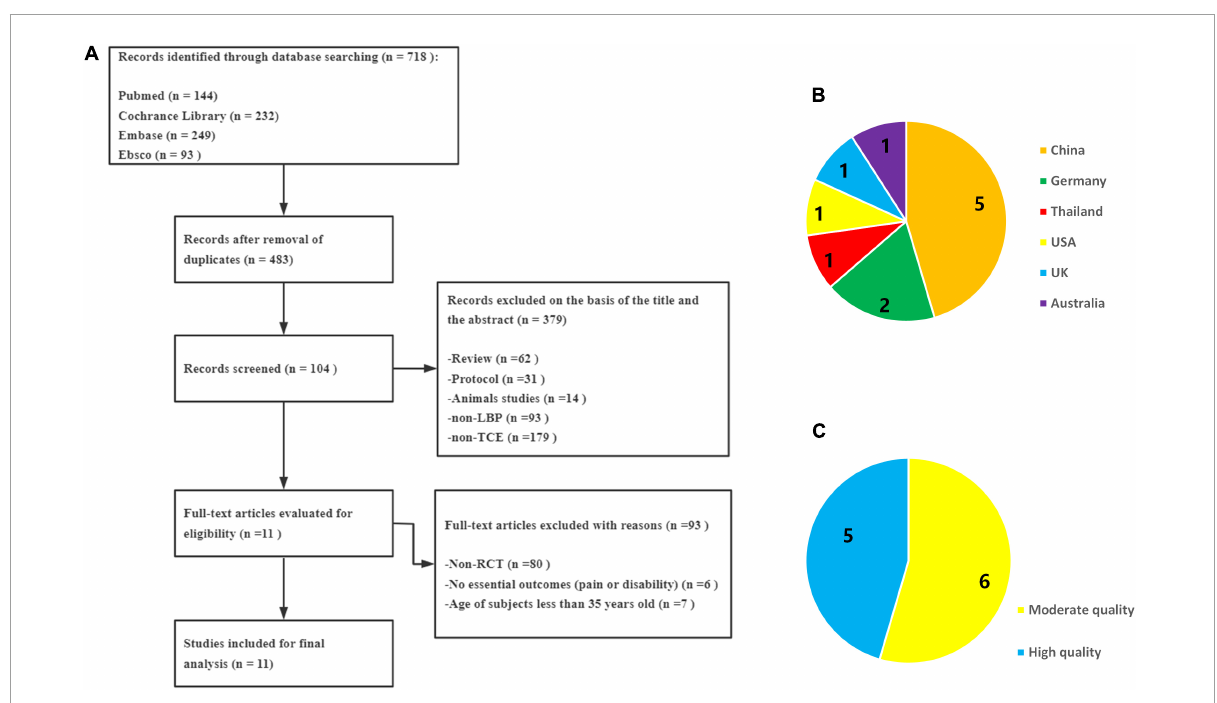
FIGURE1 (A) A PRISMA flow diagram of the literature screening and selection processes. (B) Distribution of countries. (C) Quality assessment of